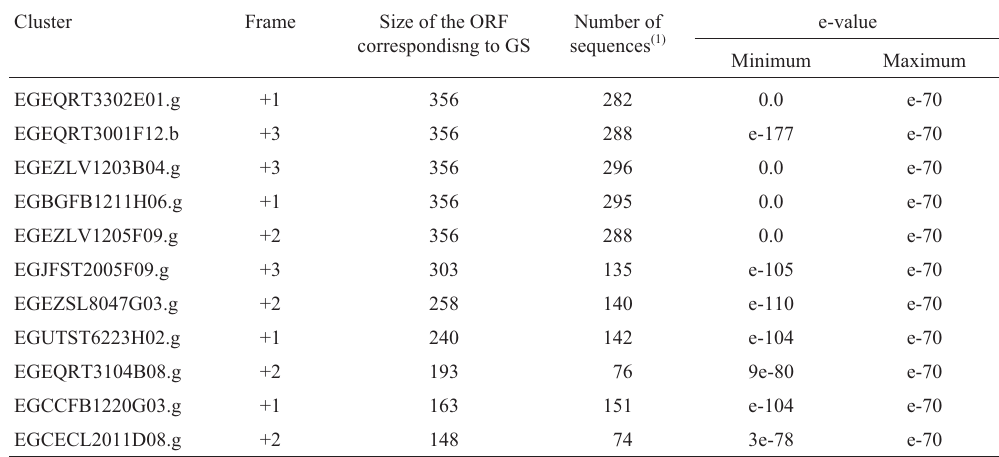
Table 3 - Translation frames for the nucleotide sequence of the clusters, minimum and maximum valures of e-value and sizes of the ORFs corresponding to the GS enzyme (Glutamine Synthetase, EC = 6.3.1.2). Cluster